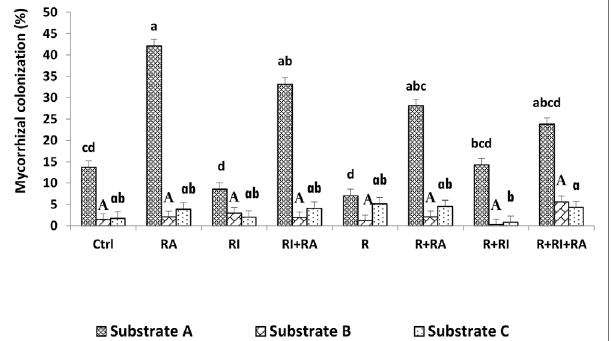
FIGURE 2 | Root mycorrhizal colonization of S. senegal seedlings that were grown on different inoculated or uninoculated substrates in nursery conditions. For each substrate, bars with the same letters do not signi fi cantly differ according to the Bonferroni step-down test at p < 0.05. (Ctrl) control; (R), Mesorhizobium plurifarium ; (RI), Rhizophagus irregularis ; (RA), Rhizophagus aggregatus.